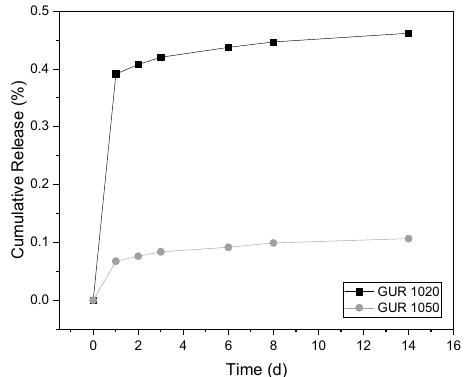
Figure 8. Cumulative AL release depending on the GUR used.